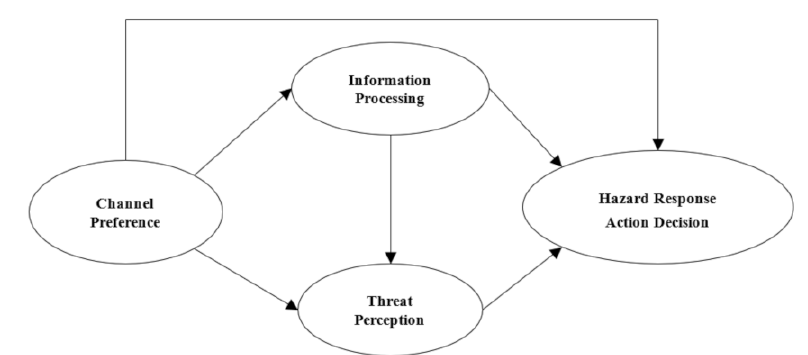
Figure 1. Schematic diagram of multi-stage decision model.